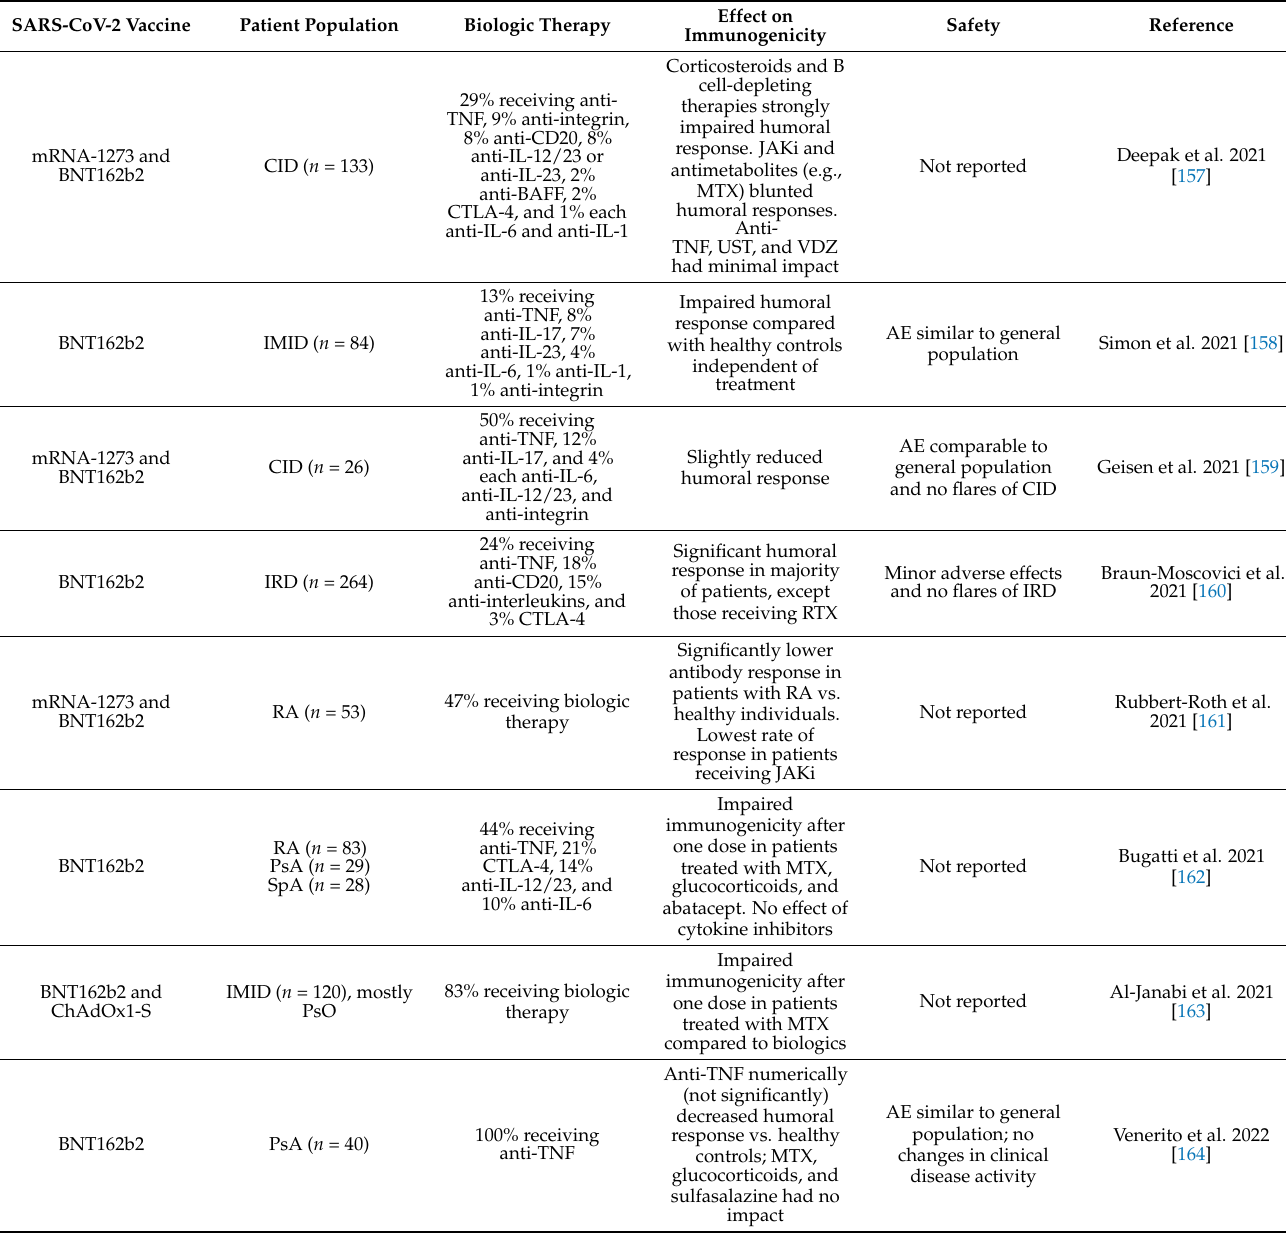
Table 3. Immunogenicity and safety of SARS-CoV-2 vaccines in